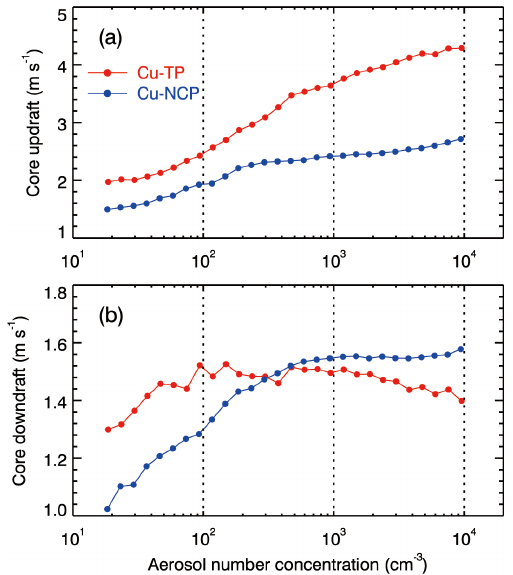
Figure 5. Simulated p mean of (a) updraft and (b) downdraft in the core area (defined as an area where the absolute vertical velocity of wind is greater than 1ms − 1 and the total condensed water content exceeds 10 − 2 gkg − 1 ) as a function of the initial [ N a ] in Cu-TP and Cu-NCP.